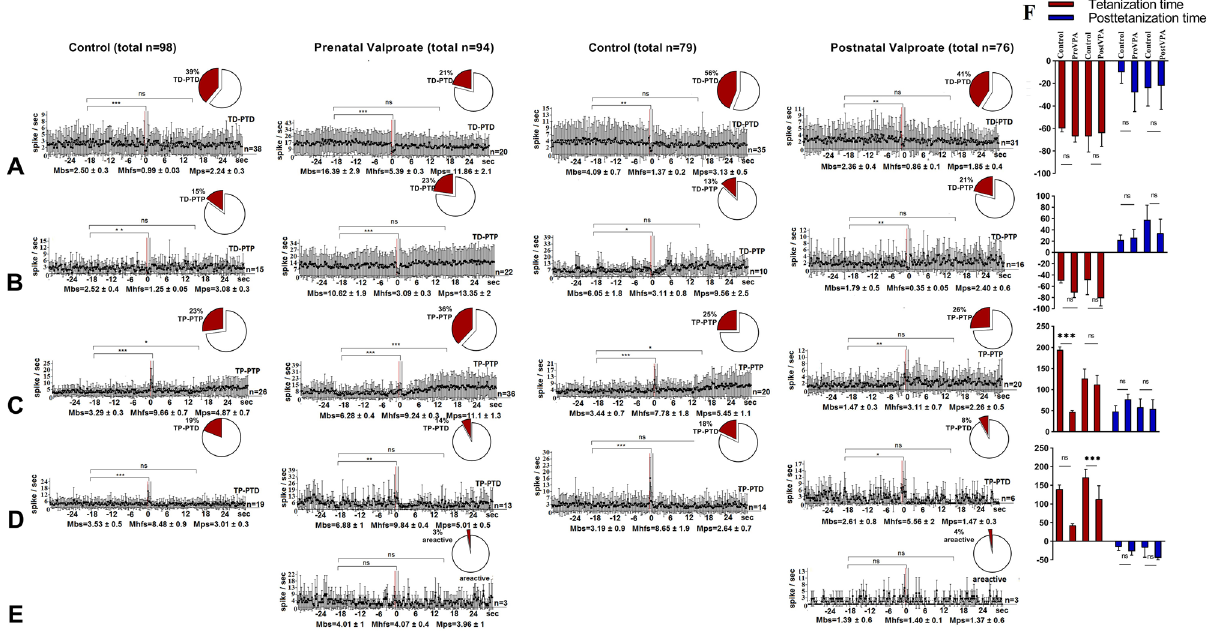
Figure 4. Electrophysiological changes in form of time histograms of peri-stimulus average spike frequency in neurons of prefrontal cortexto high-frequency stimulation of hippocampus after prenatal and postnatal VPA administration. The time histograms of peri-stimulus average spike frequency in neurons of prefrontal cortex are illustrated in the figure. The mean peri-stimulus frequency diagrams built on the basis of pre-stimulus and post- stimulus manifestations of spike activity of single PFC neurons to high-frequency stimulation of hippocampus in a real time 30 s before stimulation (Mbs), 30 s post-stimulation (Mps) and during high-frequency stimulation (Mhfs), exhibiting the specified types of response: ( A ) TD-PTD, ( B ) TD-PTP, ( C ) TP-PTP, ( D ) TP-PTD, and areactivity ( E ) in the VPA treated groups. The data are presented as mean ± SD; n = number of neurons. The statistical significance from baseline (Mbs) was estimated according to the unpaired Student’s t-test , *** p < 0.001, ** p < 0.01, * p < 0.05, ns - non significant. ( F ) The bar diagrams show the average % change relative to the baseline (Mbs, zero level) in responses of tetanization time (red) and post-tetanization time (blue) in control vs. VPA treated groups in the population of neurons with a given type of response. Statistical significance was calculated using Fisher’s exact test, * p <